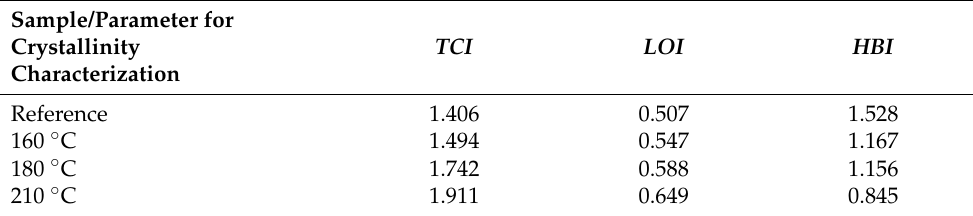
Table 7. Crystallinity characteristics of isolated cellulose. Sample/Parameter